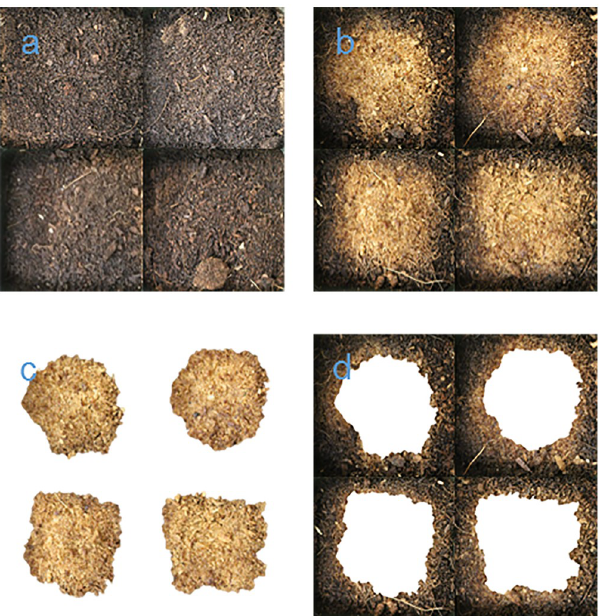
Fig 1. The pictures of 1 DAT. a: Control; b: HP treatment (before segmentation); c: Area directly affected by HP (P1; after segmentation); d: Area not directly affected by HP (P0; after segmentation).